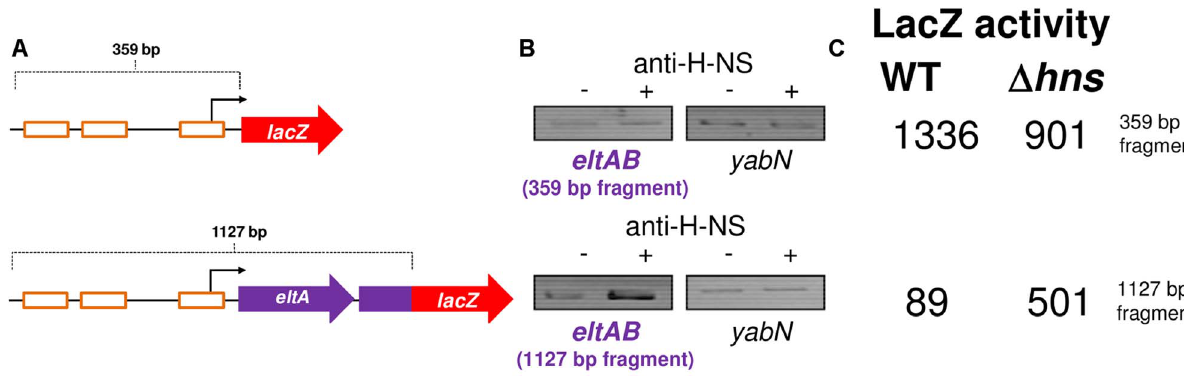
Fig. 7. The eltAB promoter is directly repressed by H-NS. A) The panel shows two P eltAB::lacZ fusions. B) The results of a ChIP-PCR analysis used to measure binding of H-NS to the two different P eltAB derivatives shown in Panel A. C) The values are b -galactsidase activity measurements for lysates of M182, or the D hns derivative, carrying the different P estA2::lacZ fusions. Assays were done in LB medium.